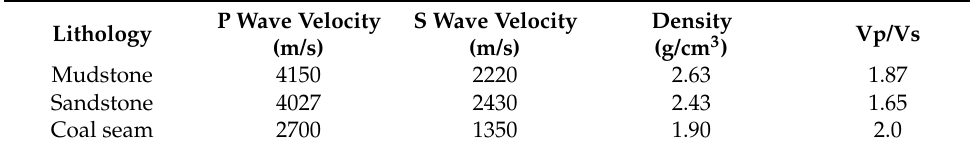
Table 1. Model parameters of thin gas-bearing sandstone with different AVO types.